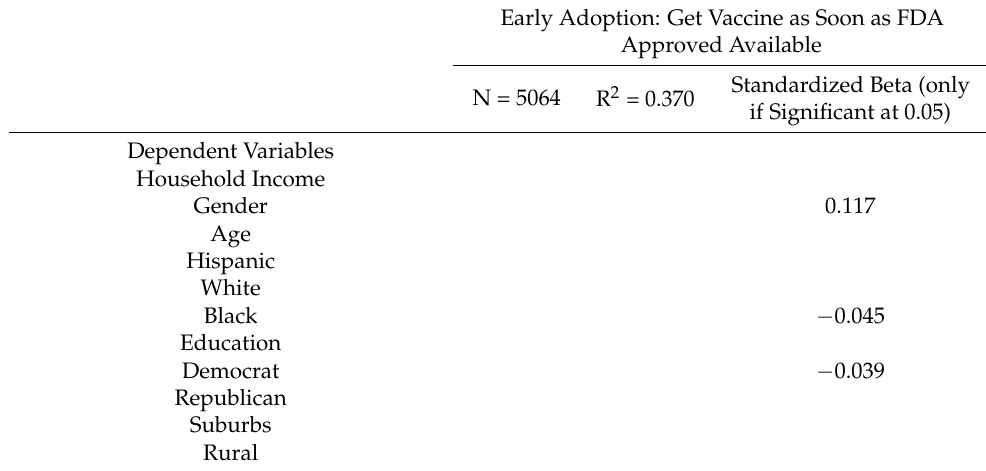
Table 9. Regression of Likelihood of Vaccine Adoption (Very, Somewhat, Not Too, Not at All) by Demographics, COVID Risk and Trust, and General Vaccine